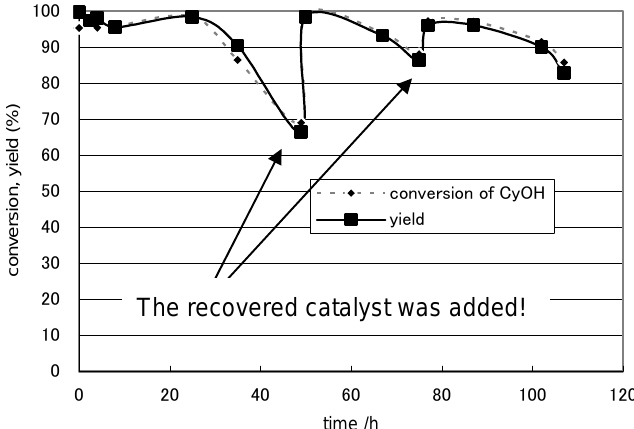
Figure 3. Continuous-flow acetylation of